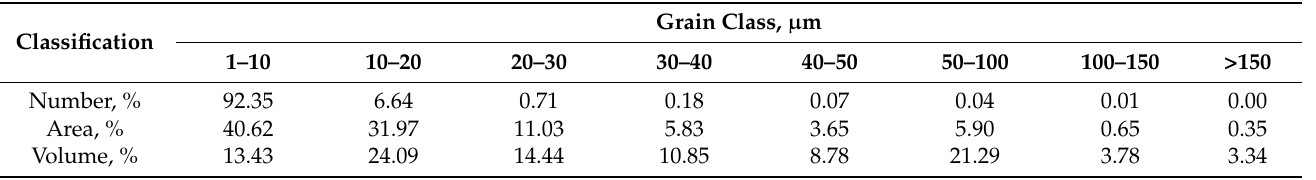
Table 2. Number, area and volume particle size classification (according to the CE Diameter parame- ter) of the ash (sample